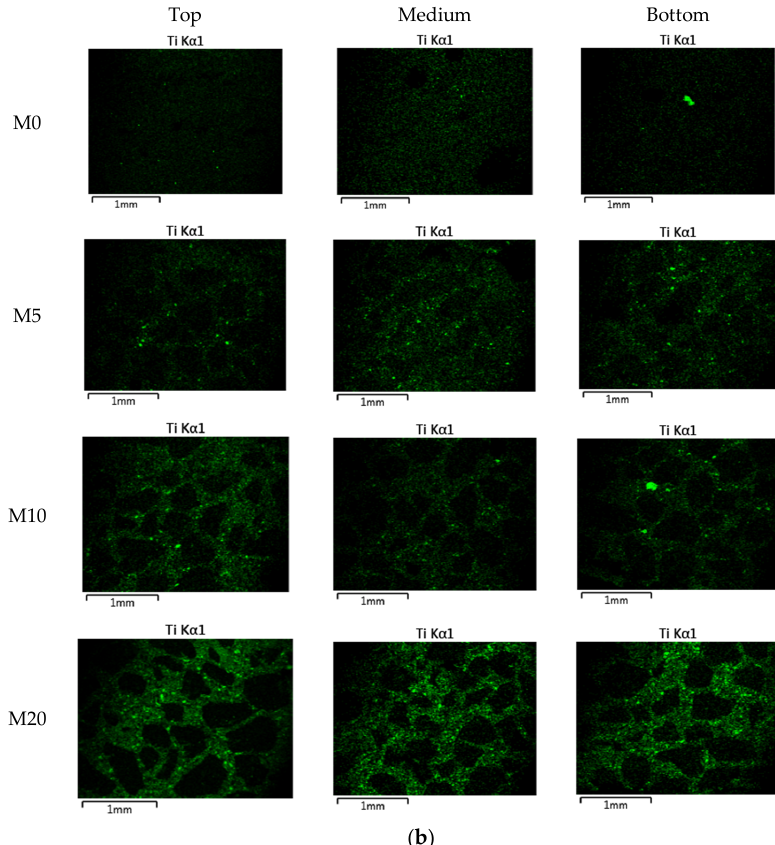
Figure 13. Ti distribution as revealed by LV-SEM with energy dispersive X-ray analysis (EDX) in cement paste and mortar specimens (green: Ti, measured in 2 mm-squares of the top, middle, and bottom faces): ( a ) C-series samples, ( b ) M-series samples. Materials 2018 , 11 , x FOR PEER REVIEW